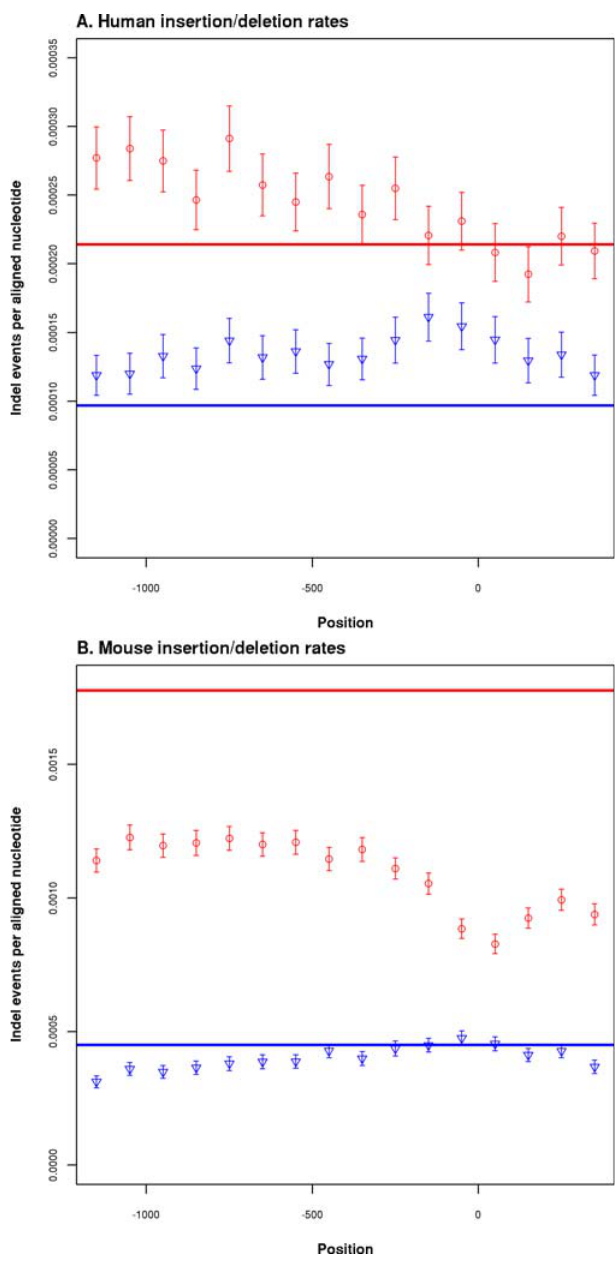
Figure 3. Micro-Insertion and -Deletion Rates Promoter rates calculated as insertion (blue) and deletion (red) events per nucleotide in 100-bp consecutive windows ( x- axis). Error bars show 95% confidence intervals; solid horizontal lines show rates calculated from AR alignments. Vertical grey line indicates the þ 1 TSS position. (A) Human rates based on alignments between human, chimpanzee, and macaque; rates shown are derived only from the human terminal branch (see Materials and Methods). (B) Mouse terminal branch rates based on comparisons between mouse, rat, and dog. DOI: